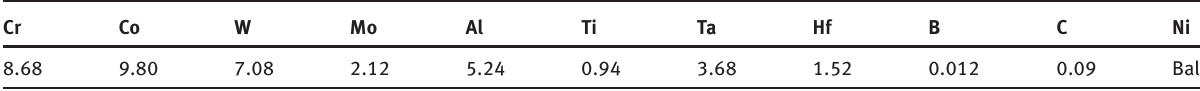
Table 1: Chemical compositions of DZ125 superalloy (mass fraction, %) Cr Co W Mo Al Ti Ta Hf